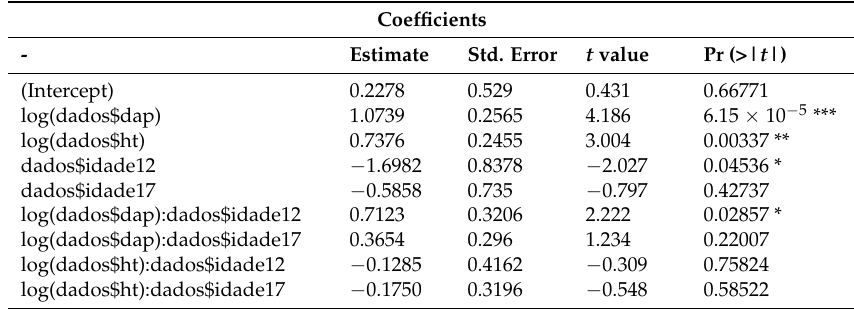
Table A13. R software output table with significance values resulting from ANCOVA for AGFM using C10 as reference for comparison with C 12 and C 17.